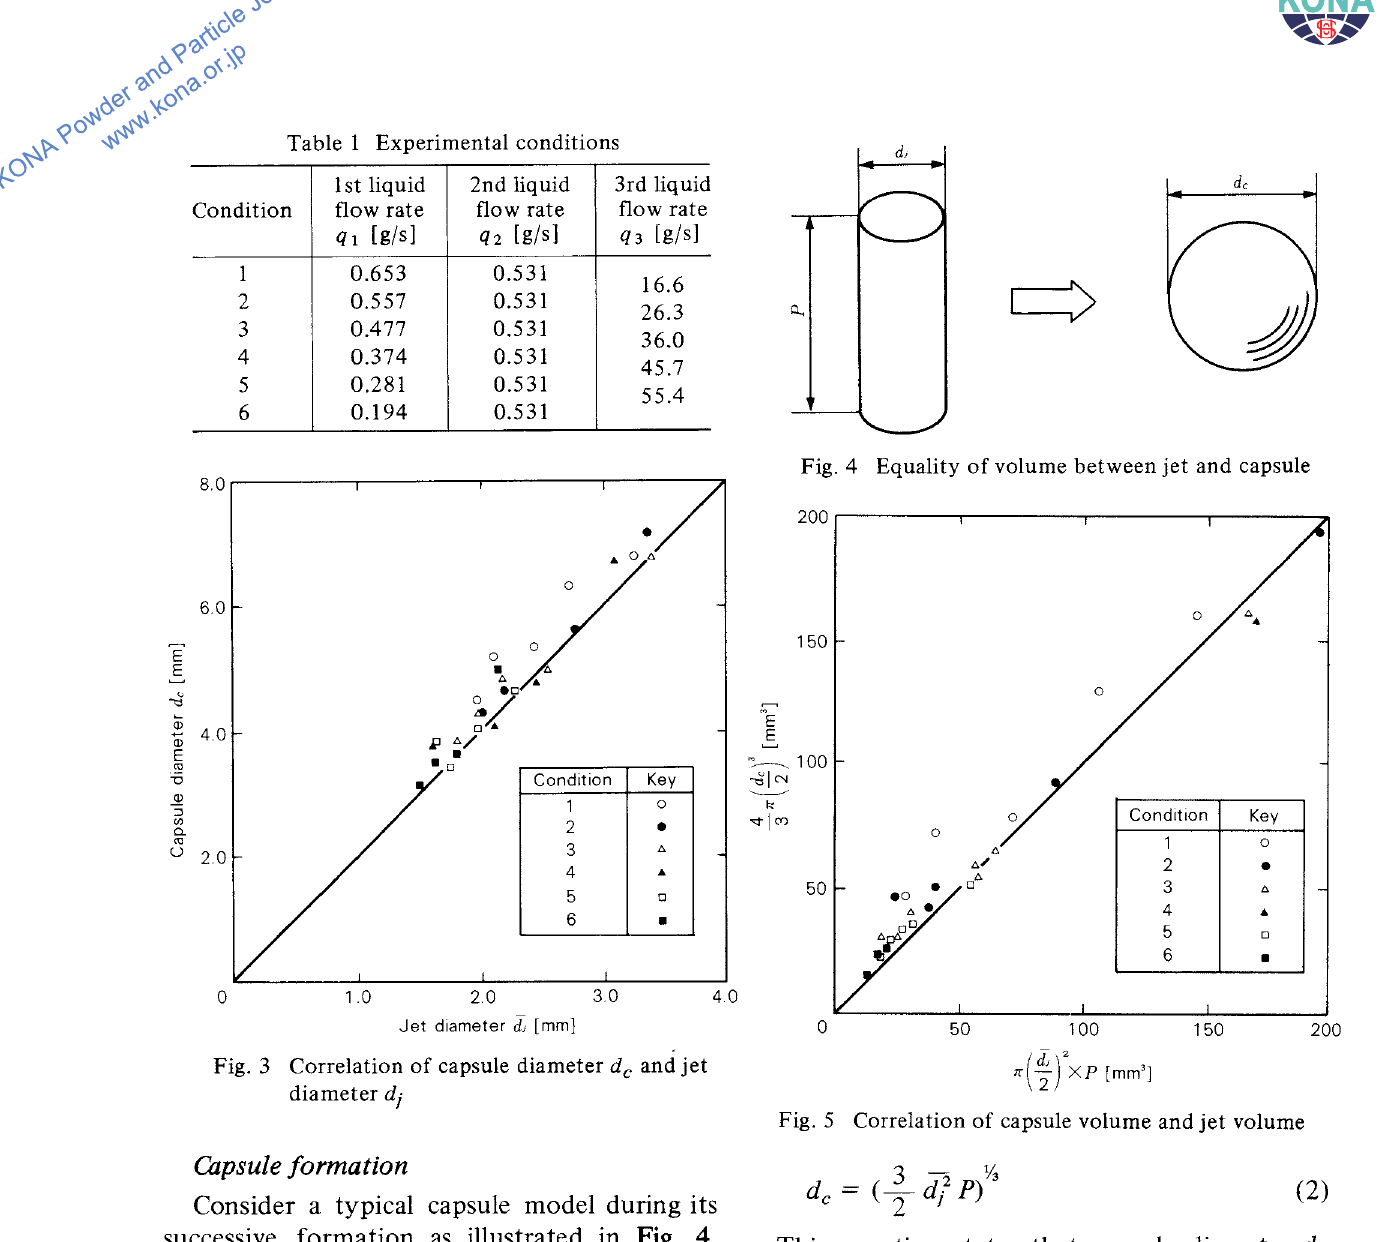
Fig. 3 Correlation of capsule diameter de and jet diameter di